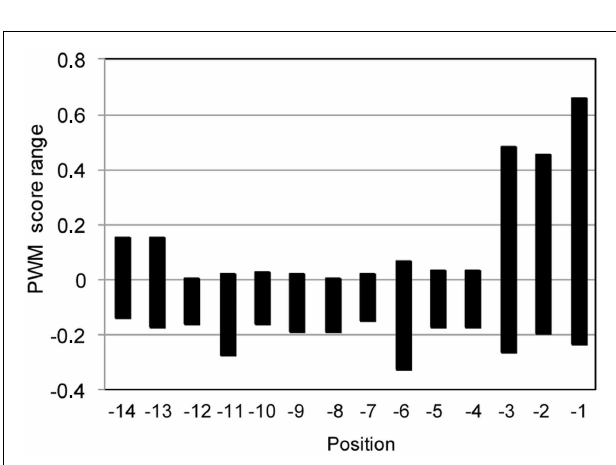
FIGURE 2 | Position-specific prediction score range of the general PWM score matrix of plant PTS1 proteins. From the matrix values of each amino acid residue the position-specific range of values has been determined and the mean value ( − 0.069) and the standard deviation have been calculated separately for the PTS1 tripeptide (0.112) and the 11 upstream residues (0.057) to color extreme aa or amino acid residues of high (green) and low (red) PWM prediction scores on the result page of PredPlantPTS1 . the threshold (e.g., 0.440 for At1g18700.2), the given sequence is predicted to contain a functional PTS1 domain ( Figures 1A,B